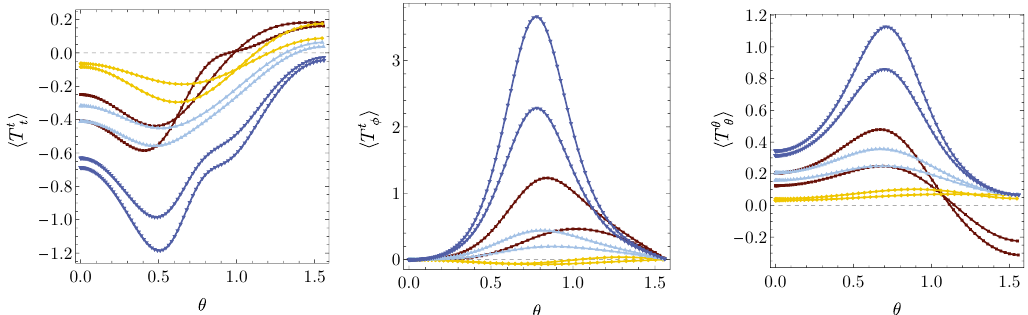
Figure 24 . Boundary energy-stress tensor components for a (cid:12)xed low temperature ( T = 0 : 2506), where there are four possible black hole phases: lowest entropy black hole branch (brown squares), small black hole branch (yellow diamonds), thermodynamically dominant middle branch (faint blue triangles) and largest entropy large black holes (blue upside-down